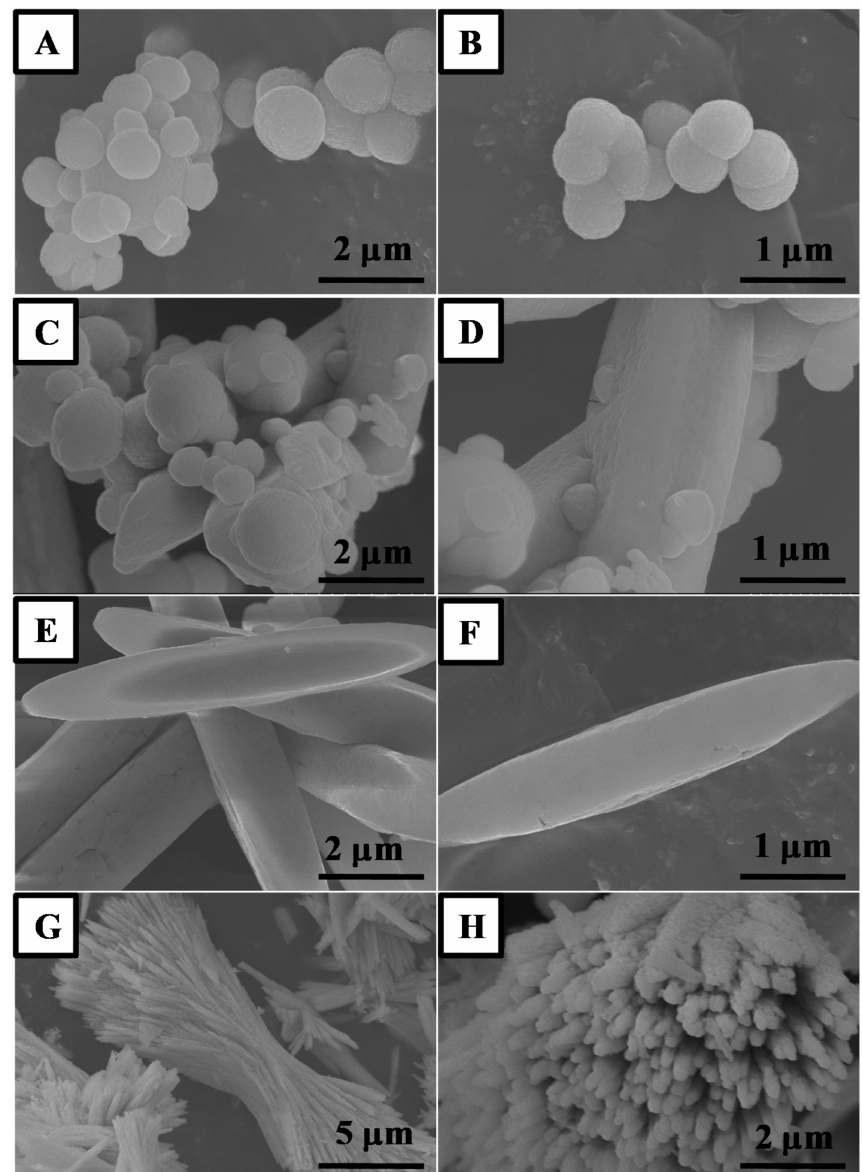
Figure 1. Low to high magnification Field-emission Scanning Electron Microscope (FESEM) im- ages of the CeO 2 sphere ( A , B ); mixed shape CeO 2 ( C , D ); CeO 2 spindles ( E , F ) and CeO 2 nanorods ( G , H ) prepared by annealing Ce(OH) 3 at 500 ◦ C for 3 h. The average diameter of CeO 2 spindles is roughly 103 nm and 1467 ± 91 nm in length suggesting shrinking of spindles by decreasing its size after calcinations. The SAED patterns of Spheres (8h-CeO 2 ), mixed shape (10h-CeO 2 ), spindles (12h-CeO 2 ) and nanorods (12h-CeO 2 ) are in agreement with XRD results. Furthermore, HRTEM images of prepared CeO 2 samples reveals dotted lines and rod axis are parallel to each other. The dotted line spacing is 3.11 Å that is concurred accurately with the (111)